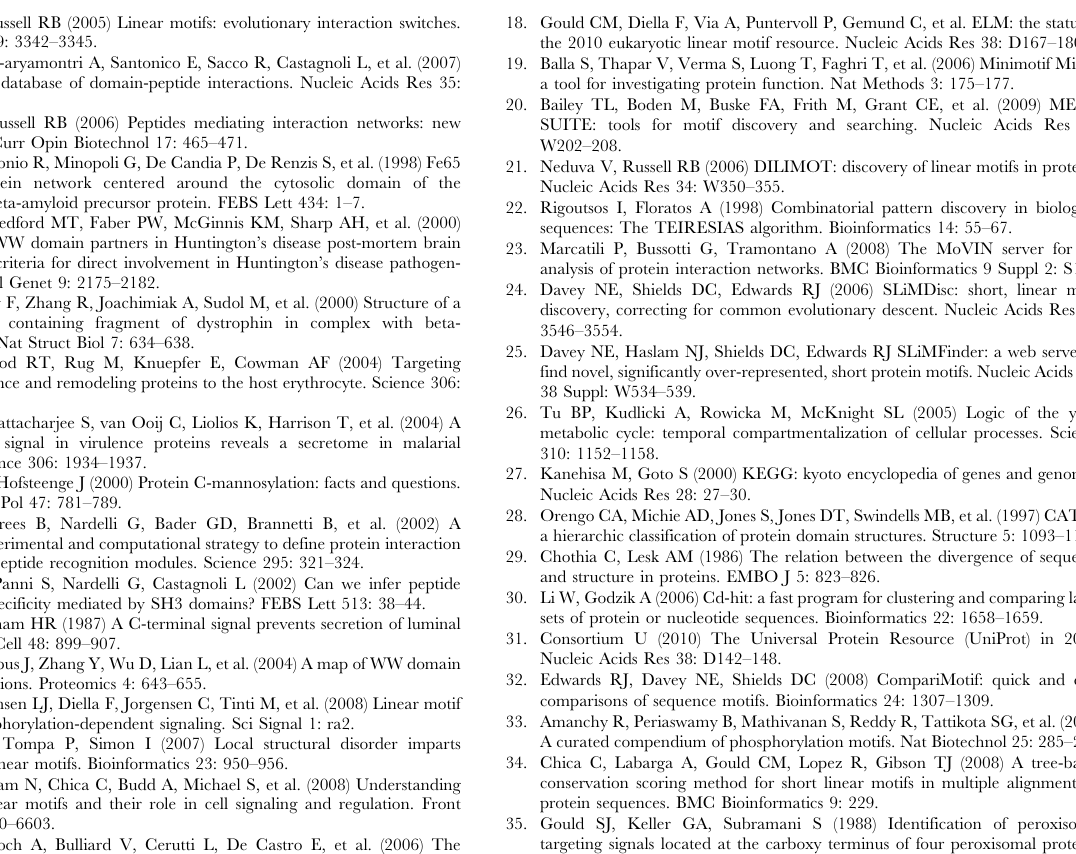
Figure S1 PROSITE and Pfam domain composition of hsa04146 KEGG pathway sequences matching the SKL $ motif. PROSITE and Pfam domain composition in the (a) 25% and (b) 40% non-redundant sequences belonging to the hsa04146 KEGG pathway and matching the SKL $ motif. Red bars indicate the position of the SKL $ motif in the sequence. Notice that there are no differences between (a) and (b). (PDF) Figure S2 PROSITE and Pfam domain composition of hsa04640 KEGG pathway sequences matching the WS.WS motif. PROSITE and Pfam domain composition in (a) 25% and (b) 40% non-redundant sequences belonging to the hsa04640 KEGG pathway and matching the WS.WS motif. Red bars indicate the position of the WS.WS motif in the sequence.